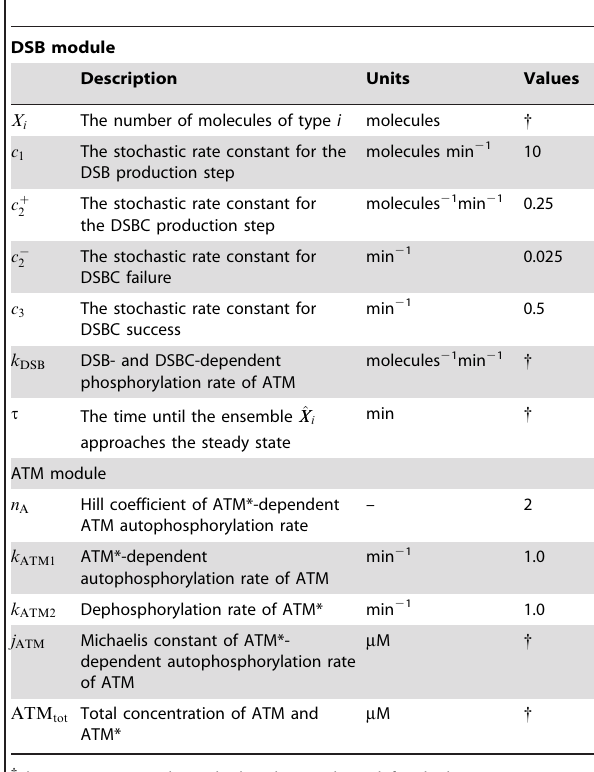
Table 1. Parameters for stochastic models of DSB and ATM